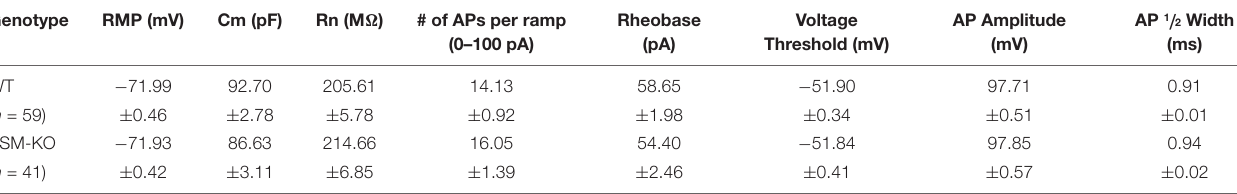
TABLE 1 | Properties of ventral hippocampal CA1 pyramidal cells in wild type and ASM-KO mice. Genotype